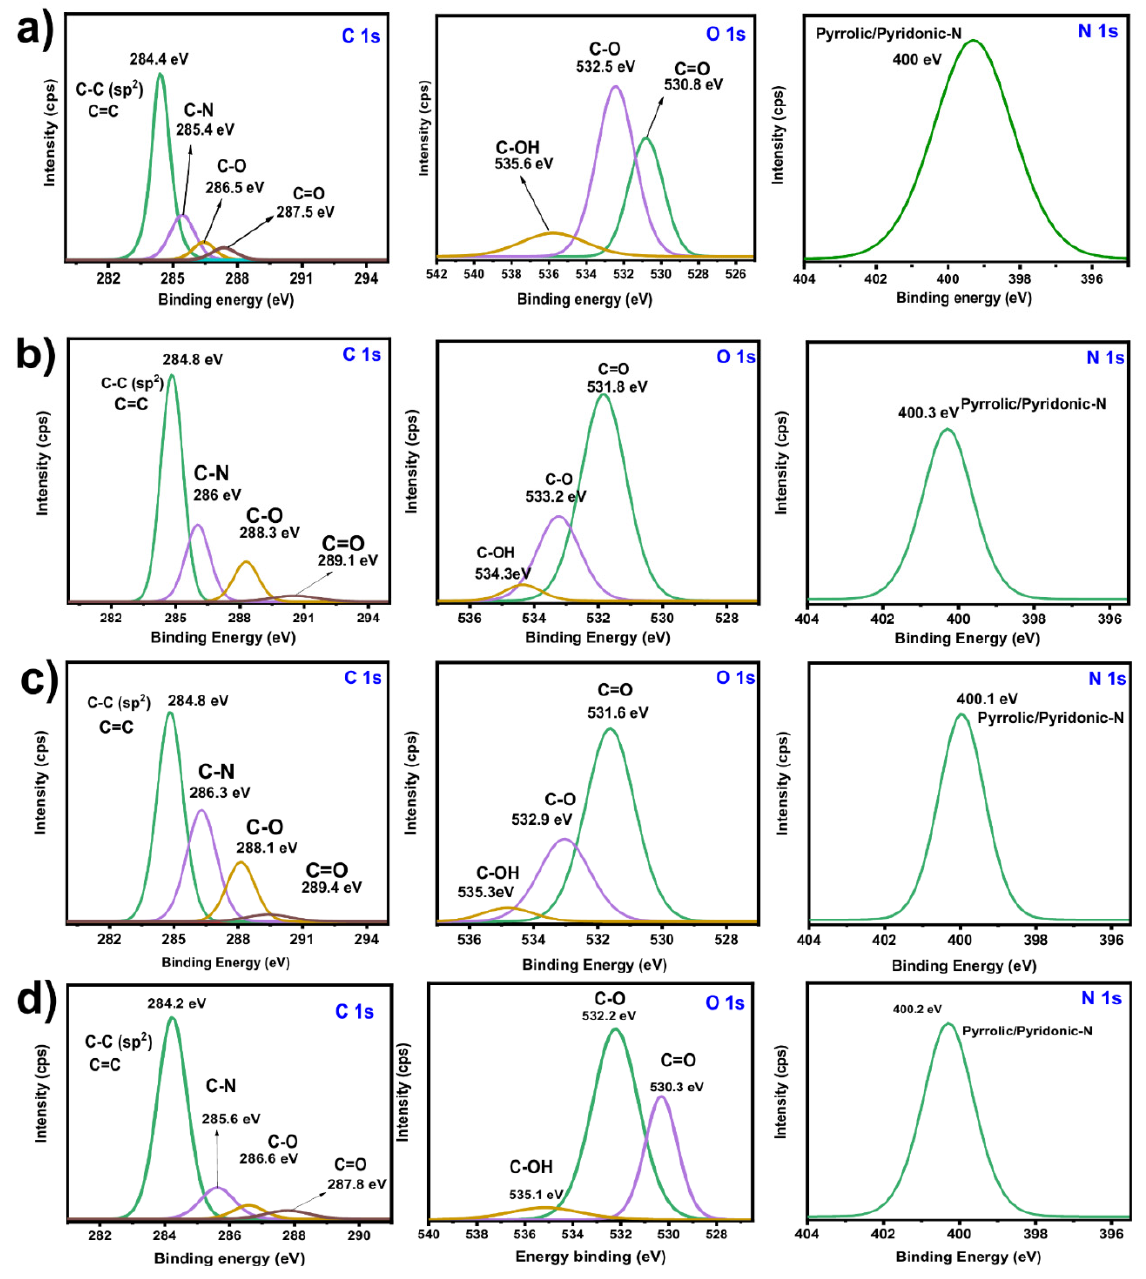
Figure 7. XPS spectra for ( a ) BC6, ( b ) BC4, ( c ) BC11, and ( d ) BC7